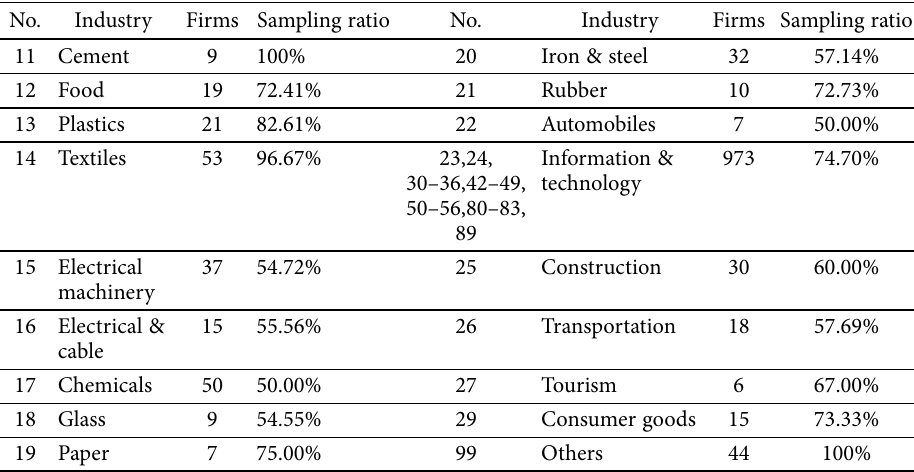
Table 1. Sample distribution by